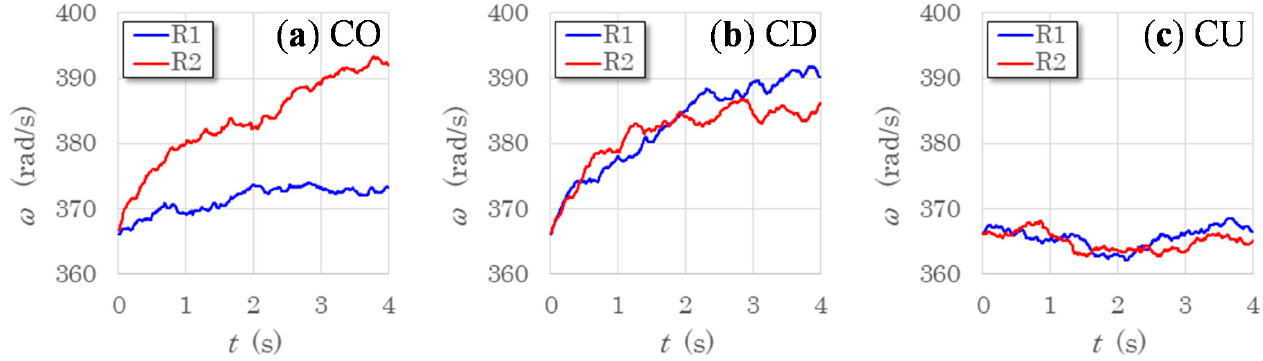
Figure 7. Time variation of angular velocity of each rotor when gap / D = 0.5: ( a ) CO layout; ( b ) CD layout; ( c ) CU layout.